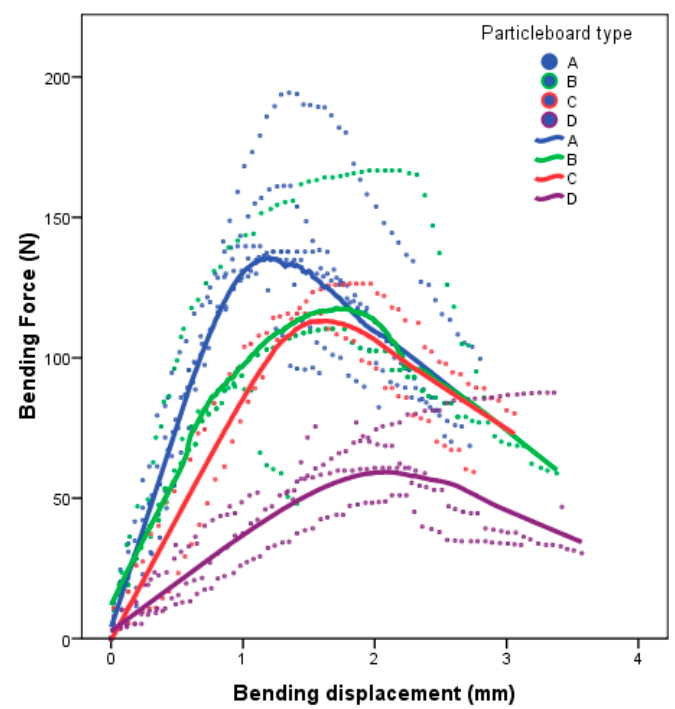
Figure 3. Average values of the bending tests for each type of particleboard.